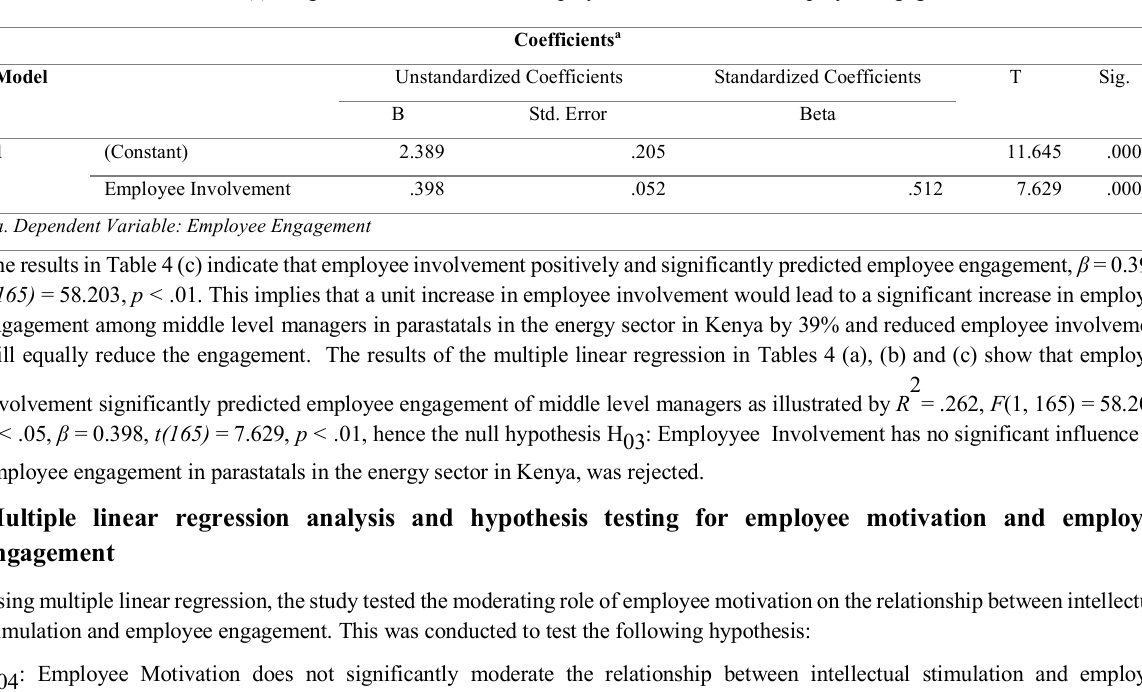
Table 4 (c): Regression coefficients for employee involvement and employee engagement